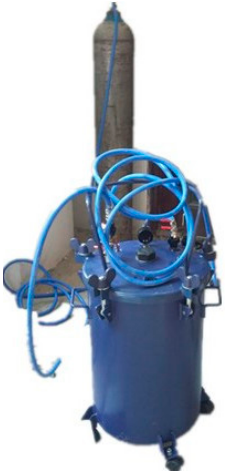
Figure 2. Apparatus of the accelerated carbonation test.